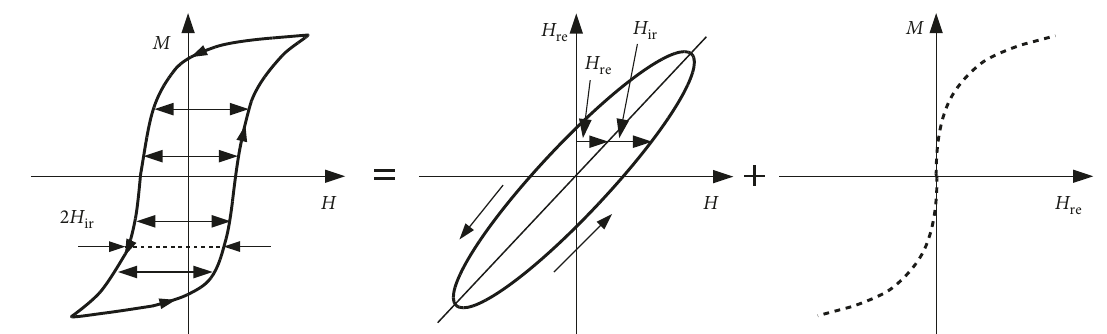
Figure 3: Block diagram of the proposed model.